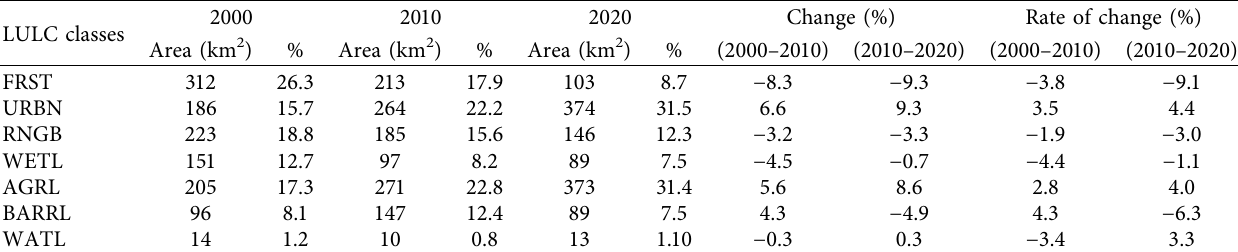
Table 7: LULC change and the rate of change comparisons for 2000, 2010, and 2020.